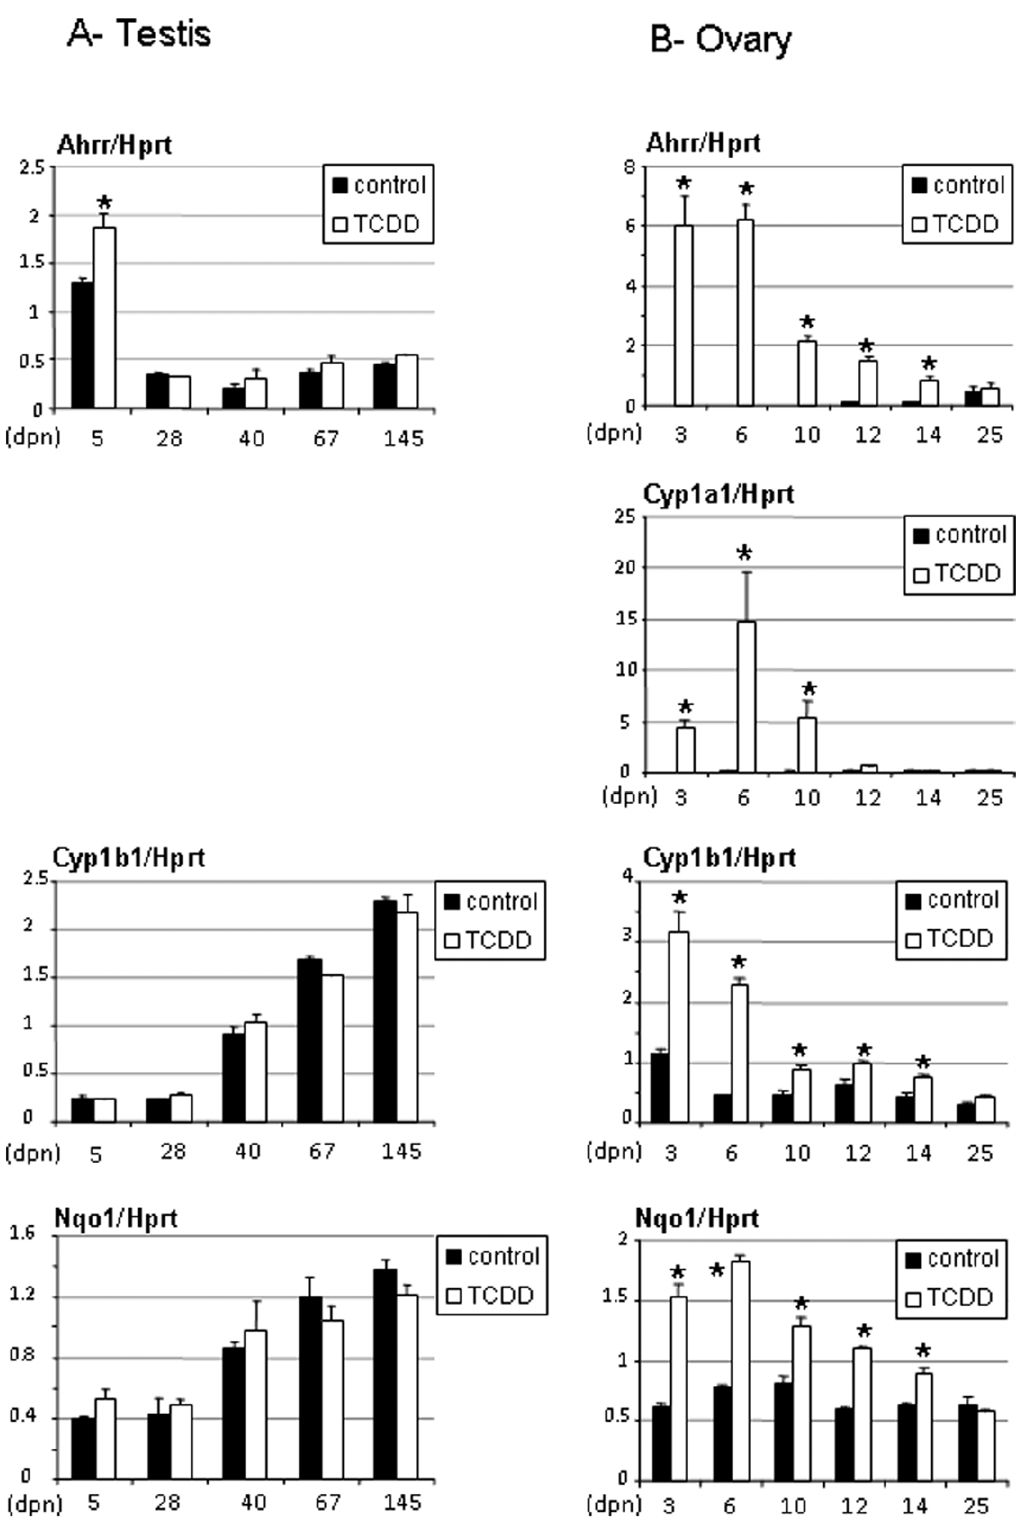
Figure 2. Ahrr, Cyp1a1, Cyp1b1 and Nqo1 gene expression levels in testes and ovaries of rats exposed in utero to TCDD. Testes were recovered from males aged from 5 to 145 days (A) and ovaries were recovered from females aged from 3 to 25 days (B). Testes samples did not have detectable Cyp1a1 levels (A). Levels were normalized using Hprt. Values are the mean 6 SEM of n=4 to 6 animals (n=2 for 3- and 25-day control ovaries). *p , 0.05 versus its time-matched control. (dpn), days postnatal.